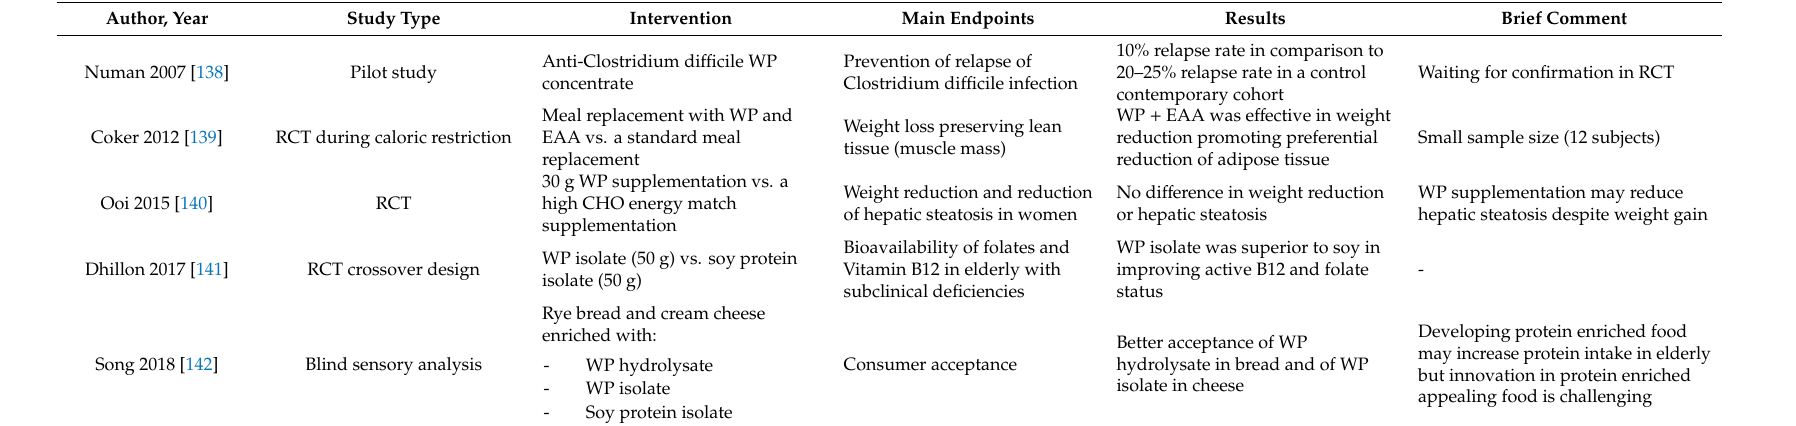
Table 4. Preliminary reports have been published in other investigational